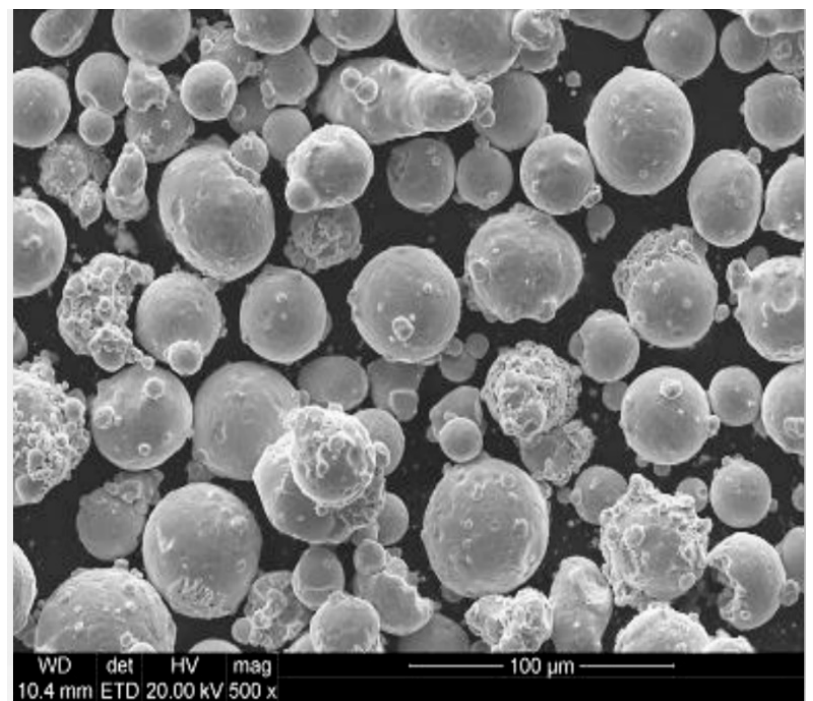
Figure 4. SEM investigation of AM Corrax powder raw material. Image courtesy of voestalpine